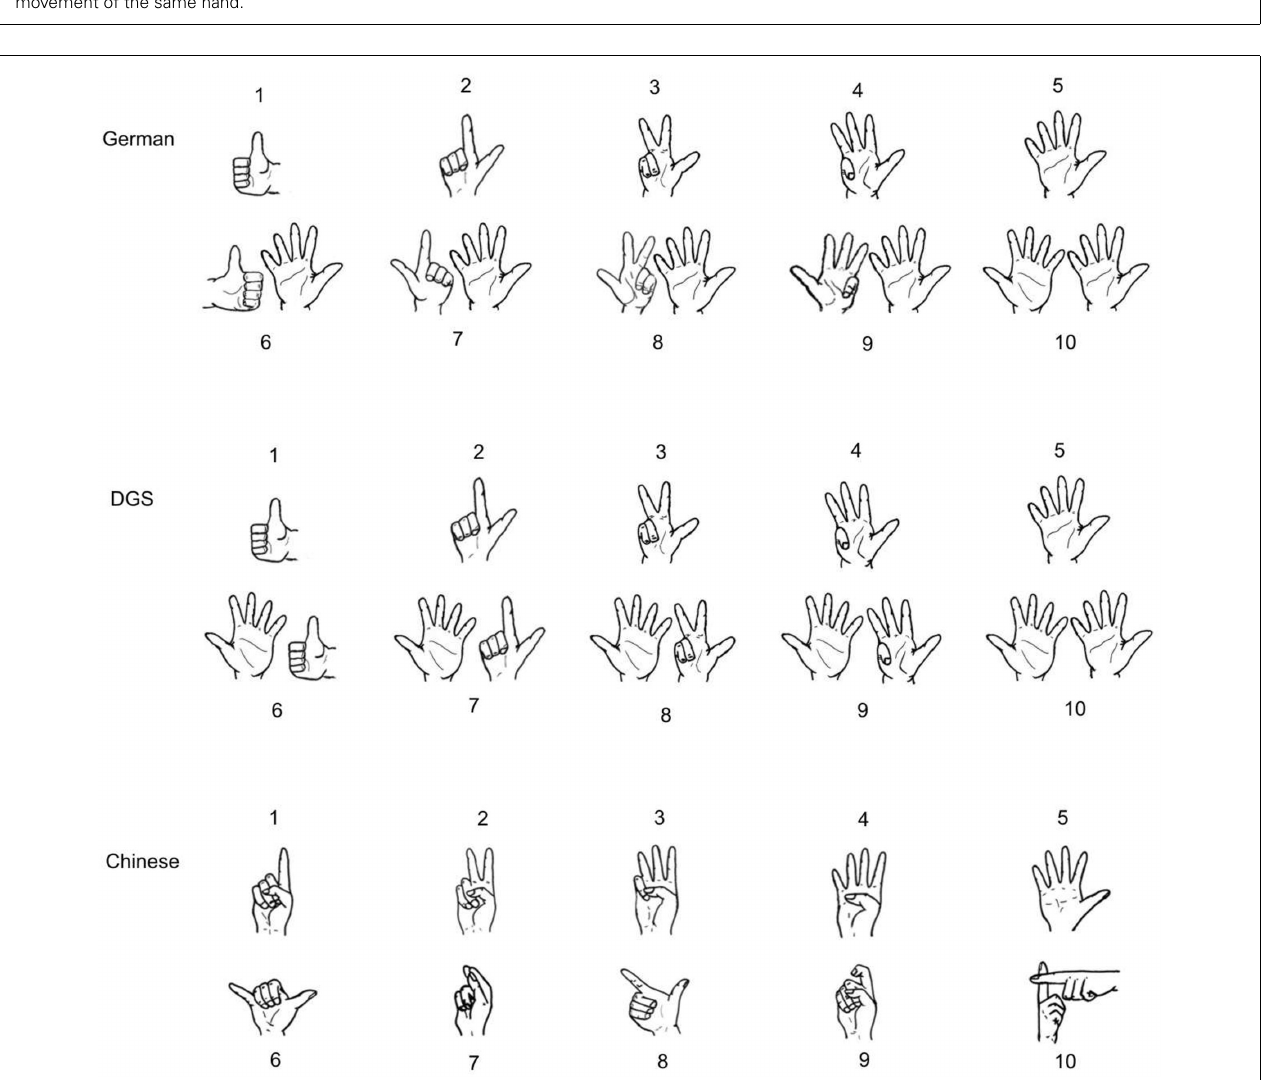
Frontiers in Psychology |